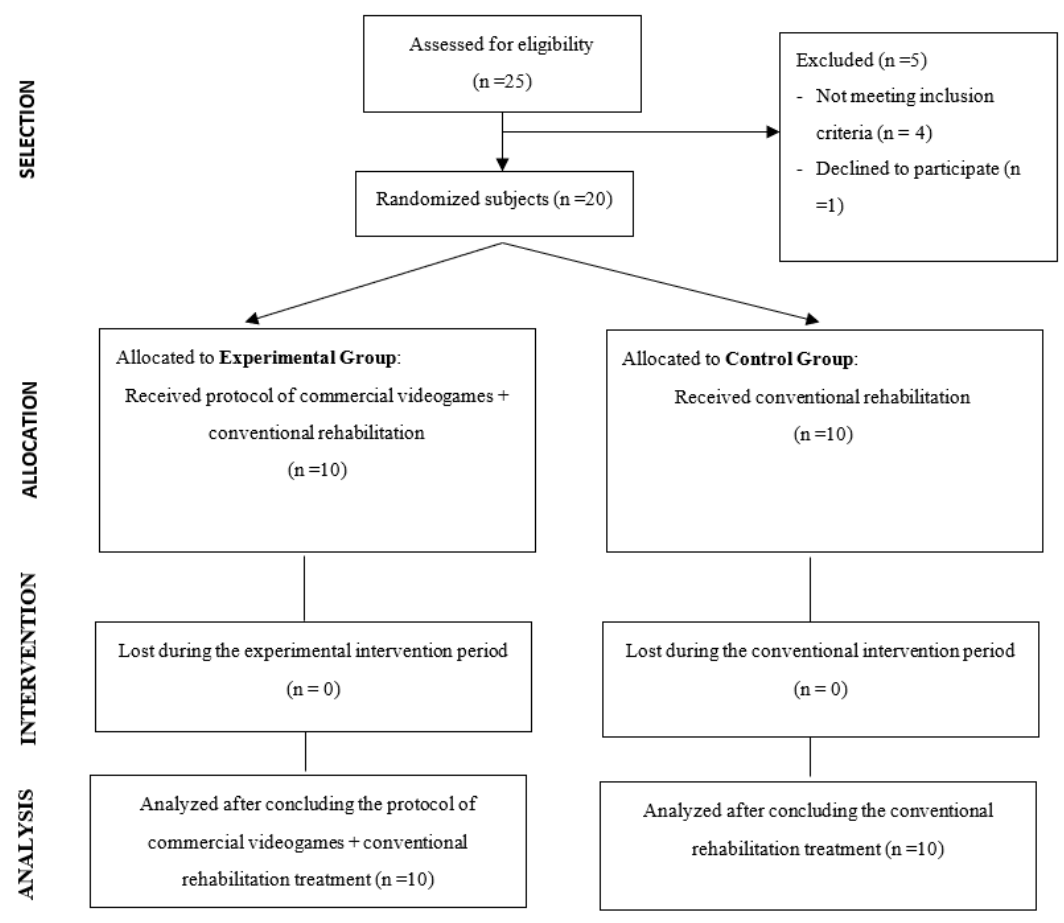
Figure 3. Flow Figure 3. Flow chart.